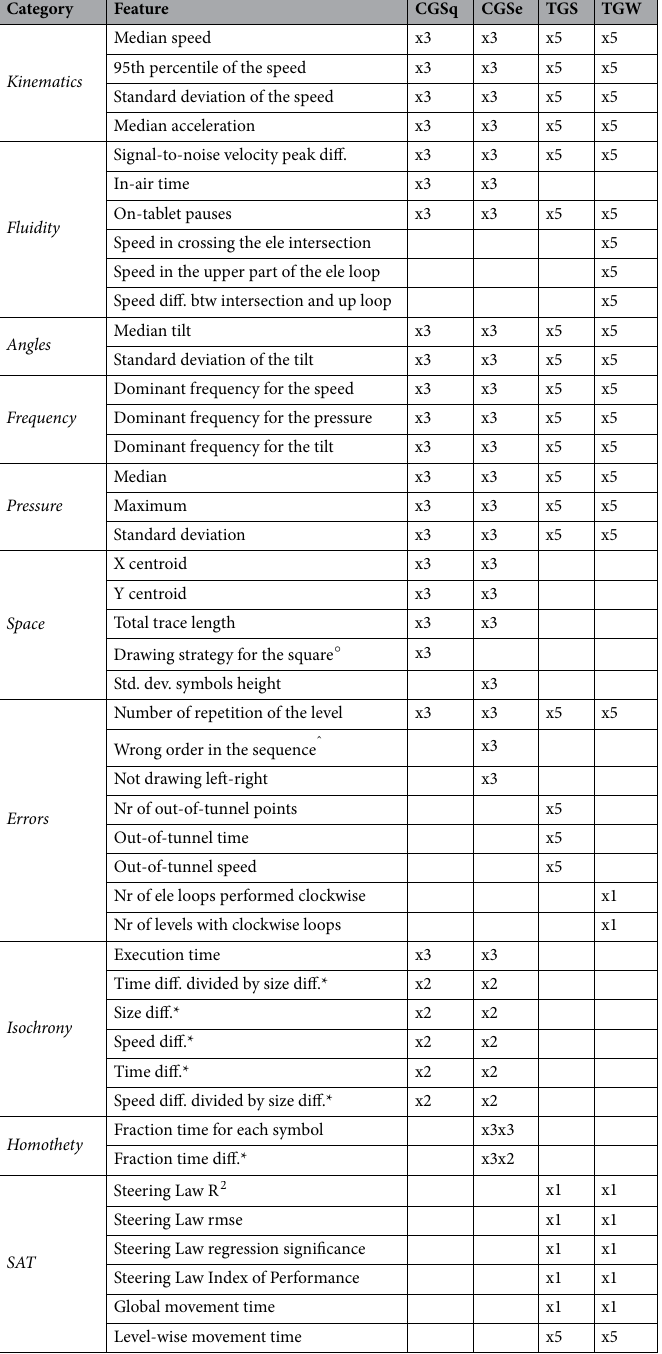
◦ Starting point and the ∗ Difference between spontaneous and big